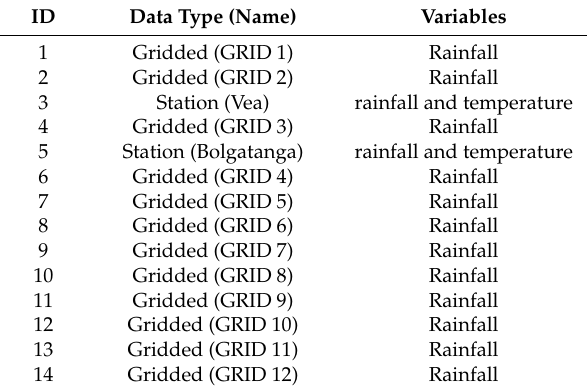
Table 1. Climate data used from the period 1985–2016.